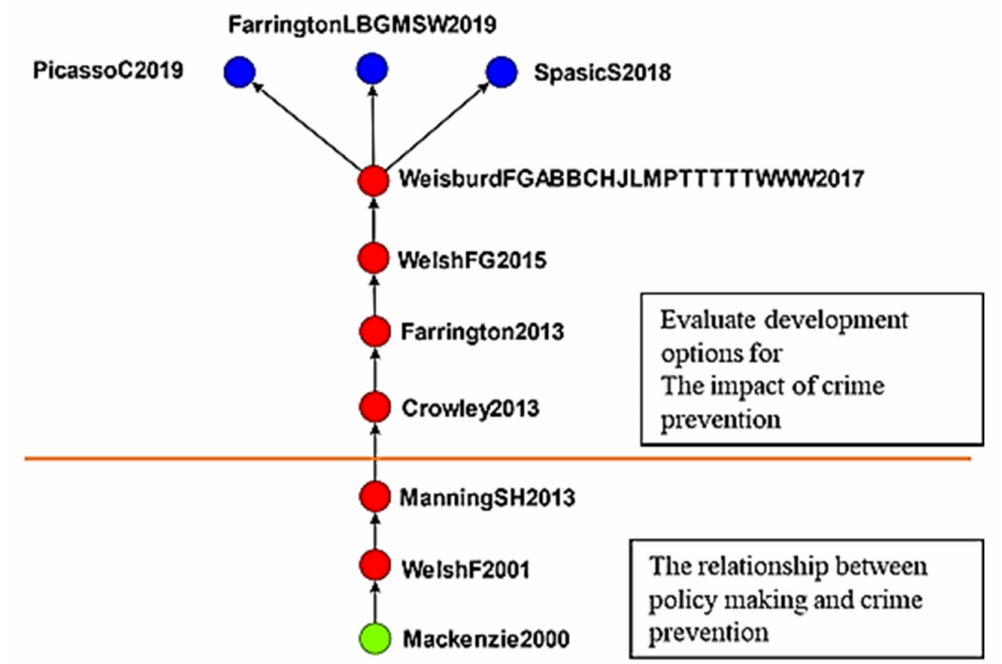
Figure 8. Global main path of third cluster. (Top to bottom). Evaluating the effects of developmental crime prevention; relationship between policy and crime